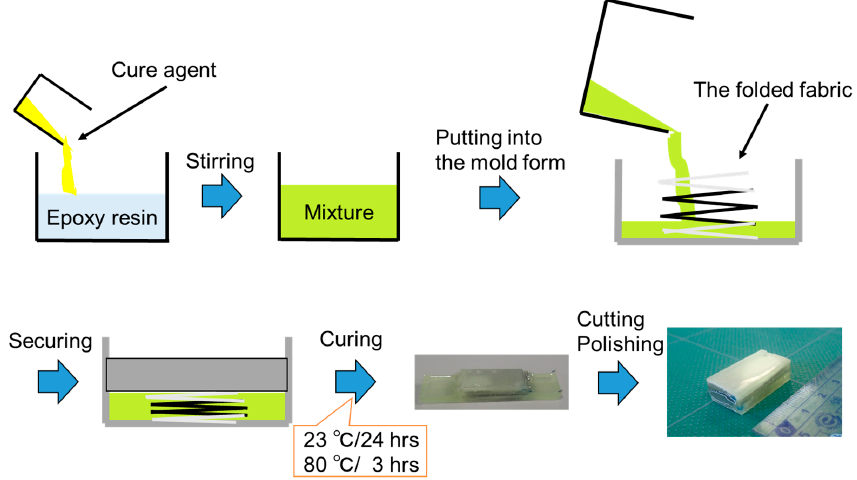
Scheme 1. Scheme of sample fabricating procedure.